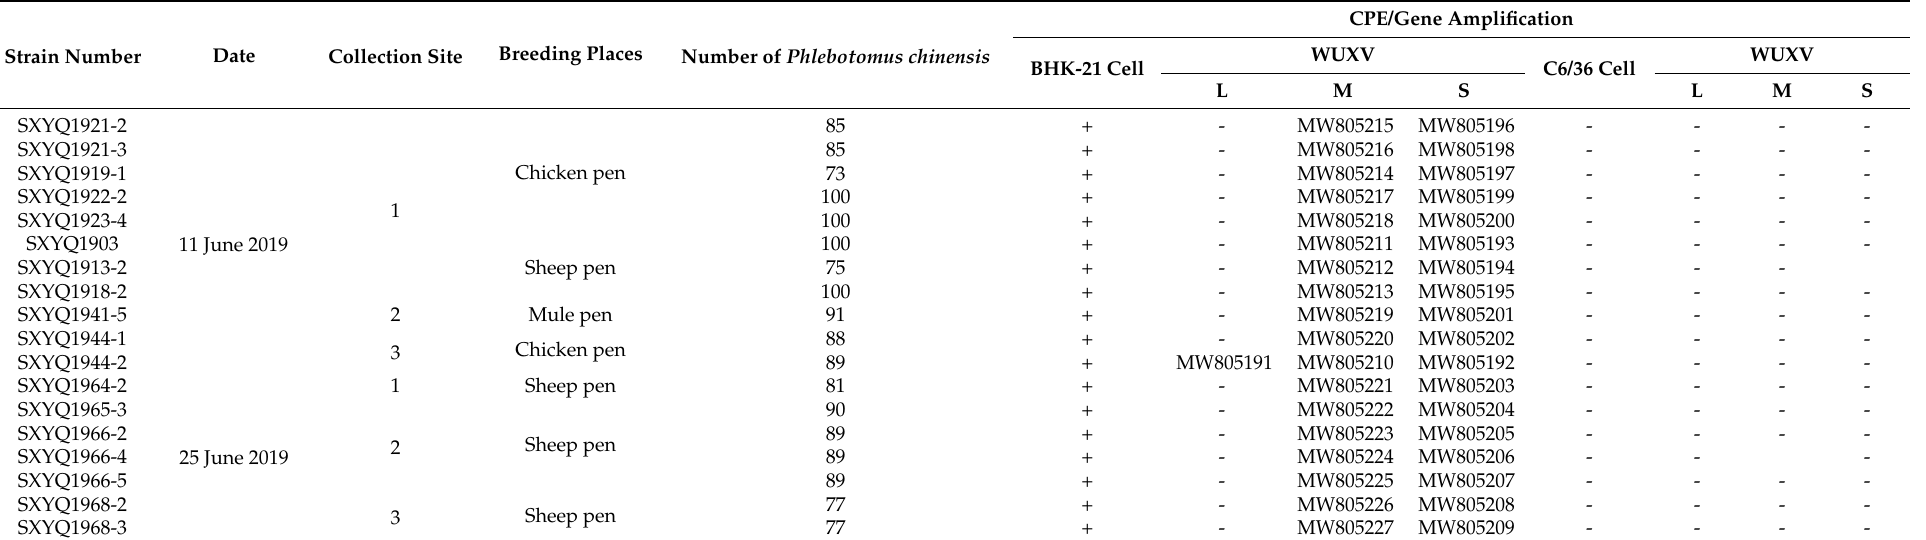
Note: ‘+’ indicates the presence of CPEs. ‘-’ indicates the absence of CPEs. 1, 2, and 3 represent the three sampling